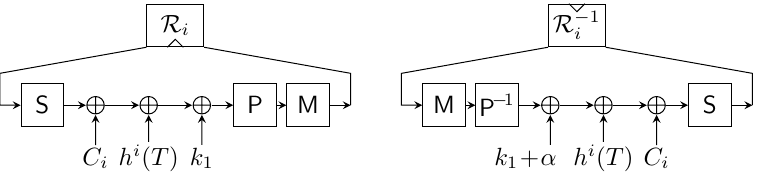
Figure 2: The MANTIS round functions R i and R − 1